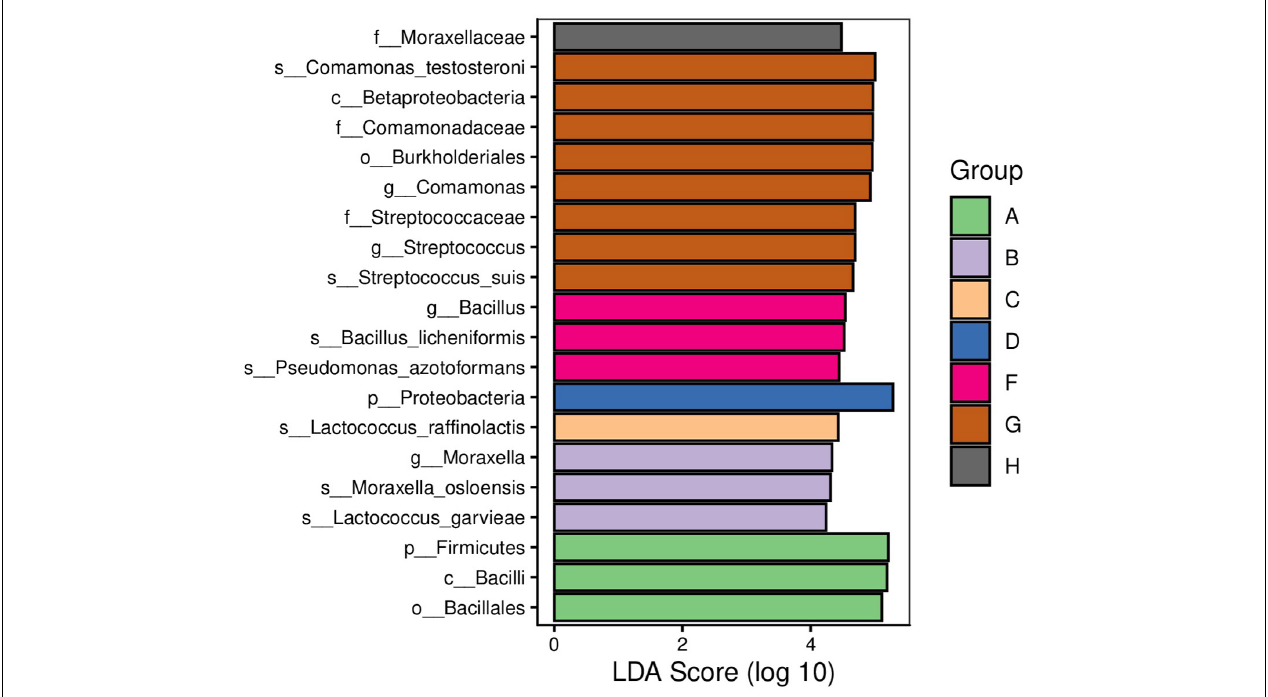
FIGURE 6 | Linear discriminant analysis (LDA) of raw milk samples used in this study. A. Heilongjiang, B. Inner Mongolia, C. Gansu, D. Henan, E. Anhui, F. Jiangsu, G. Chongqing, and H.